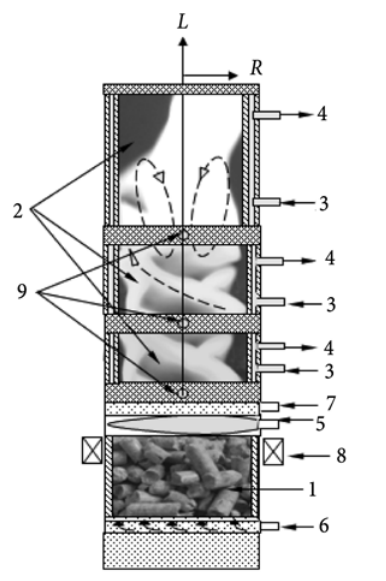
Fig. 1. Pilot scale-up: 1 – wood fuel gasifier; 2 – water-cooled combustor; 3 – inlets of cooling water flow; 4 – outlets of cooling water flow; 5 – gas burner; 6 – nozzle of primary air supply; 7 – nozzle of secondary air flow; 8 – permanent magnets; 9 – diagnostic